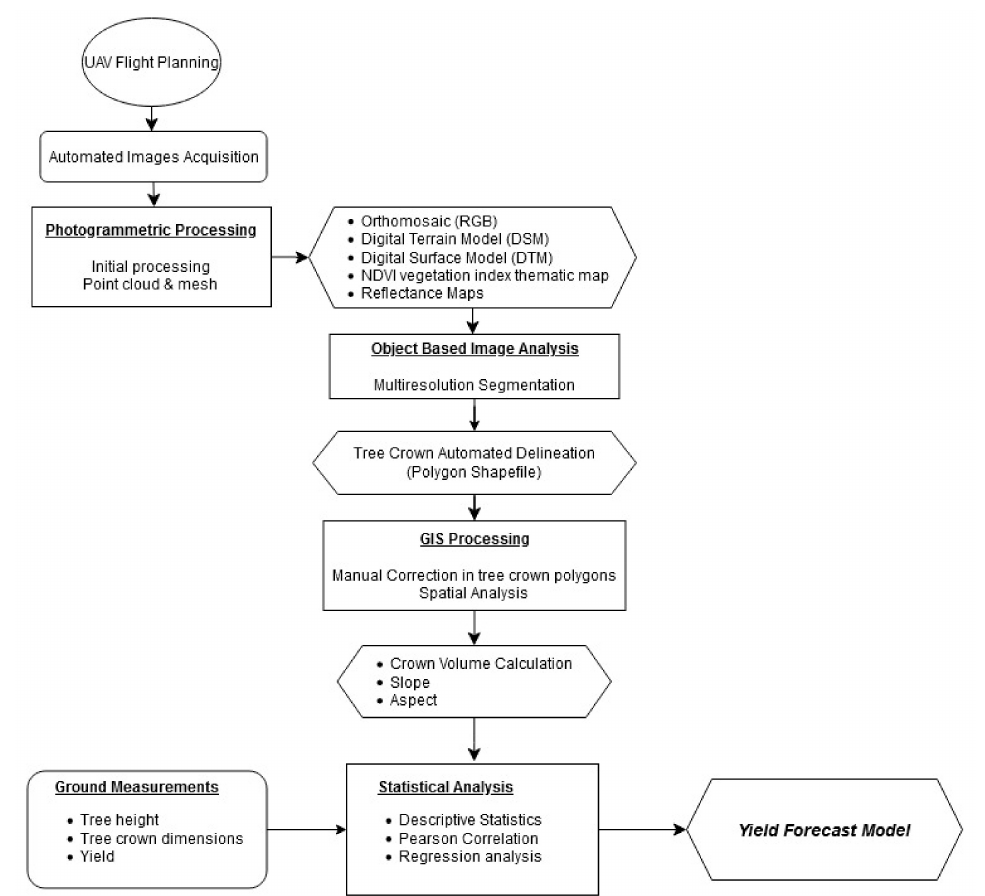
Figure 1. Flow chart displaying the procedure of creating the yield forecast